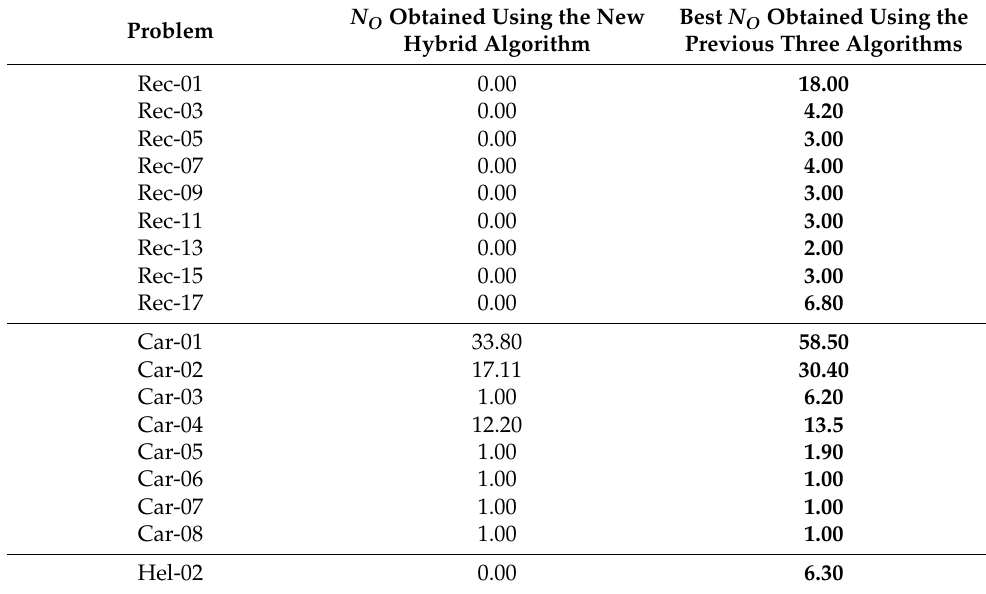
Table 9. Comparison of the N O using the new hybrid algorithm and the previous three